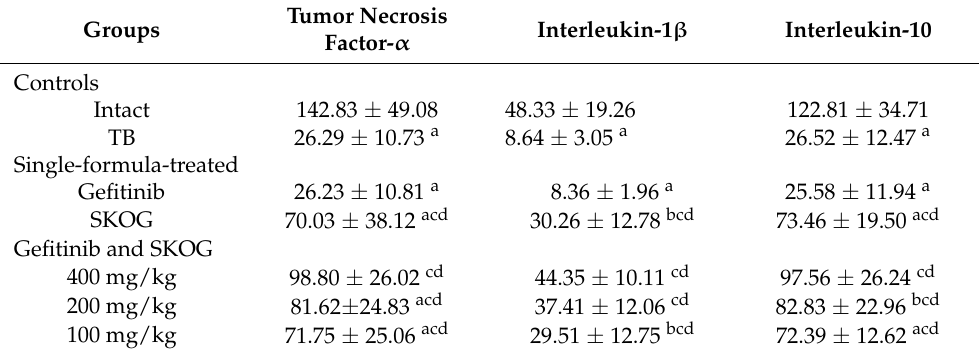
Table 5. Changes in the splenic cytokine contents in NCI-H520 tumor cell xenograft mice. Tumor Necrosis Groups